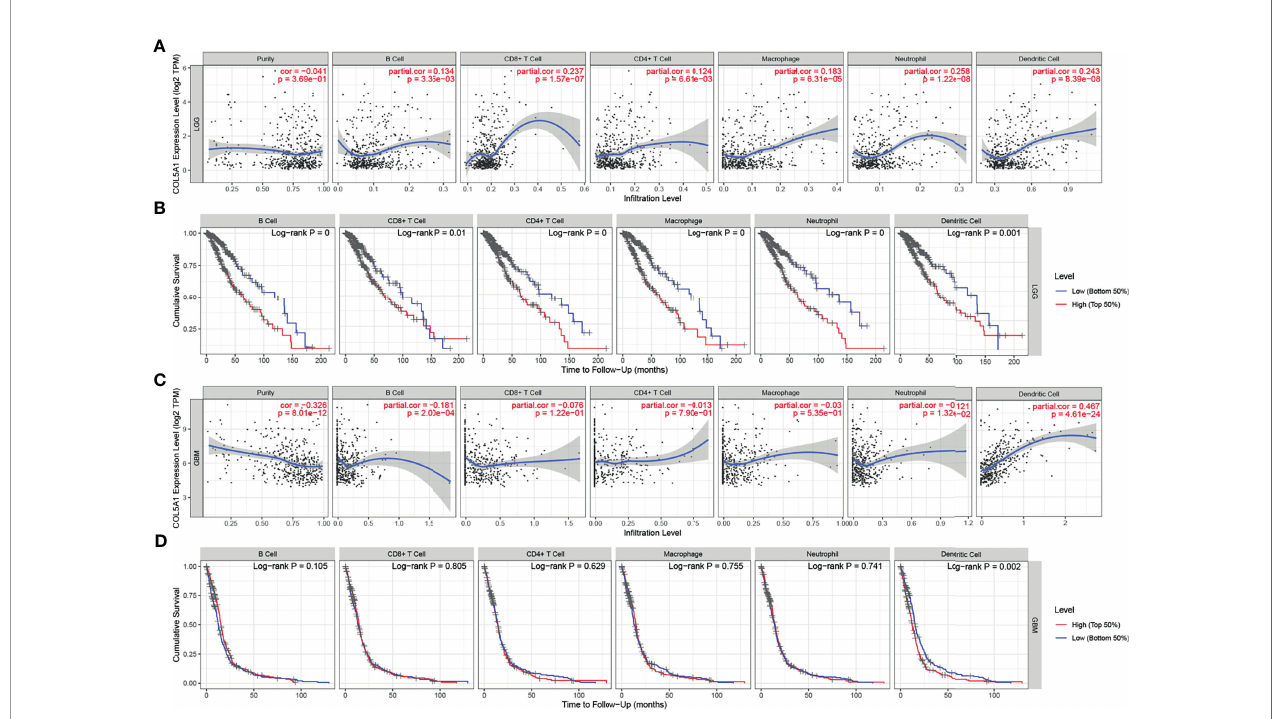
FIGURE 5 | Analysis of tumor-in fi ltrating immune cells (TIICs) based on COL5A1. (A, C) The correlation analysis of COL5A1 and TIICs in LGG and GBM. (B, D) Survival analysis based on TIICs in LGG and GBM. (cor, correlation coef fi cient; partial.cor, partial correlation coef fi